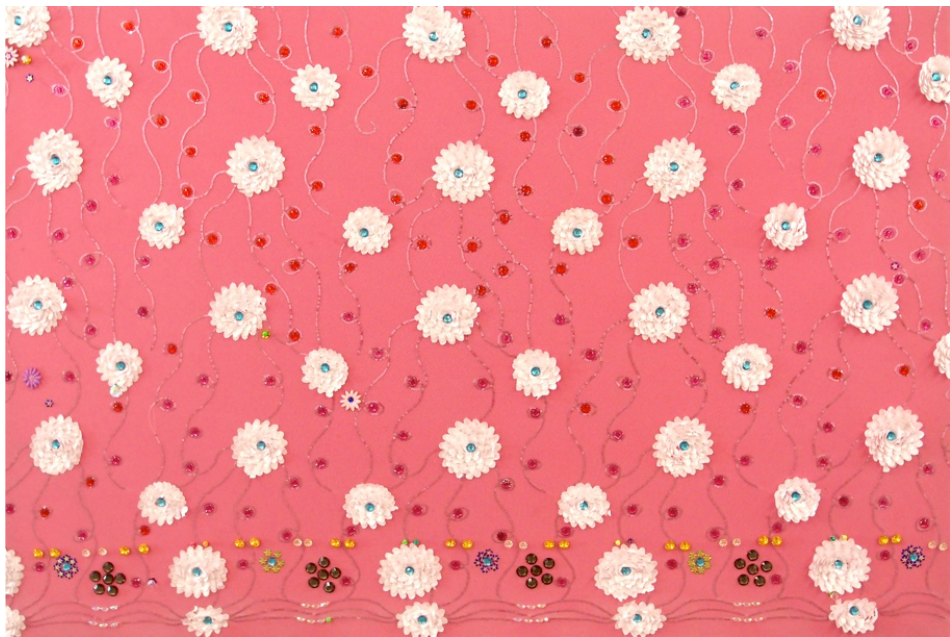
Chan Dany, Sampot: The Collection of Small Things (Diamond in the Flower), 2013. Lycra, lace, plastic beads, sequins, cotton thread. 100 x 150 cm. Photograph by Lim Sokchanlina. Courtesy of the artist and SA SA